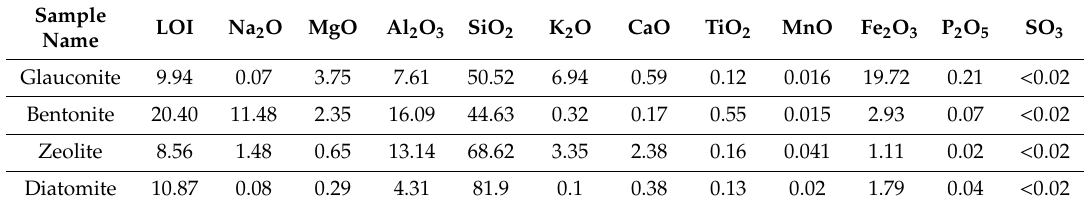
Table 1. Chemical composition of the examined samples,